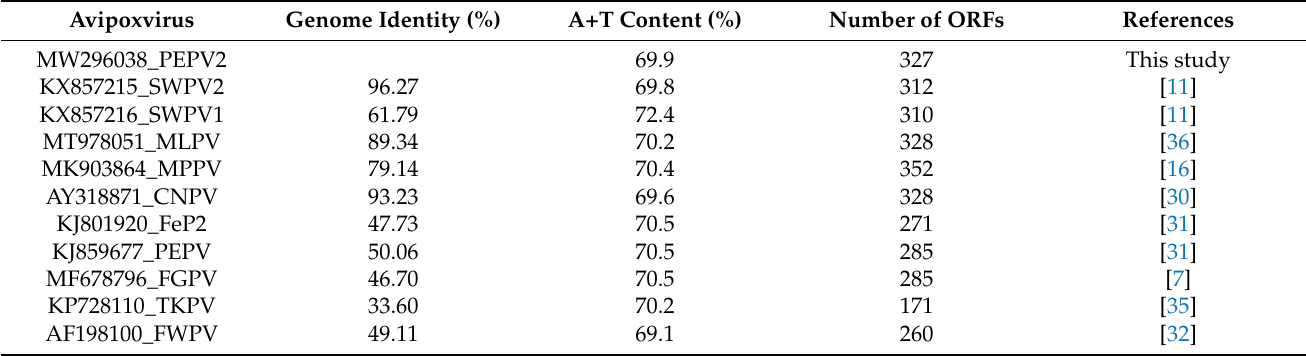
(Table 1) (GenBank accession no. KX857215) [11]. In comparison with another penguin- pox virus (PEPV; GenBank accession number KJ859677) sequenced from an African pen- guin [31], the penguinpox virus 2 sequenced in this study was significantly different (showing only 50% nucleotide identity). The A+T content of the PEPV2 genome was >69%, which shared greatest similarity with other sequenced avipoxviruses from passerine and shearwater bird species (Table 1). Table 1. Comparative analysis of representative avipoxviruses and PEPV2 based on complete genome nucleotide sequences. Avipoxvirus Genome Identity